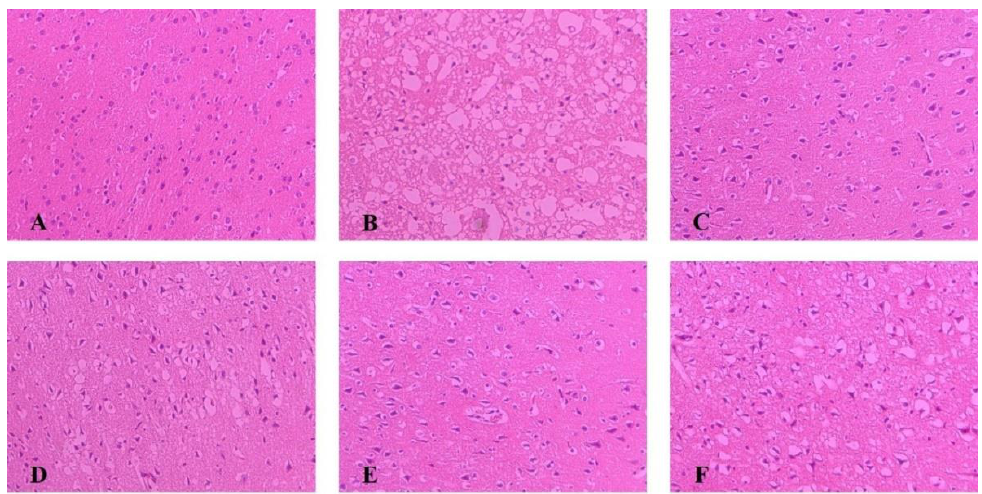
Figure 3. Histopathological changes in the cerebral cortex of rats in each group were observed by